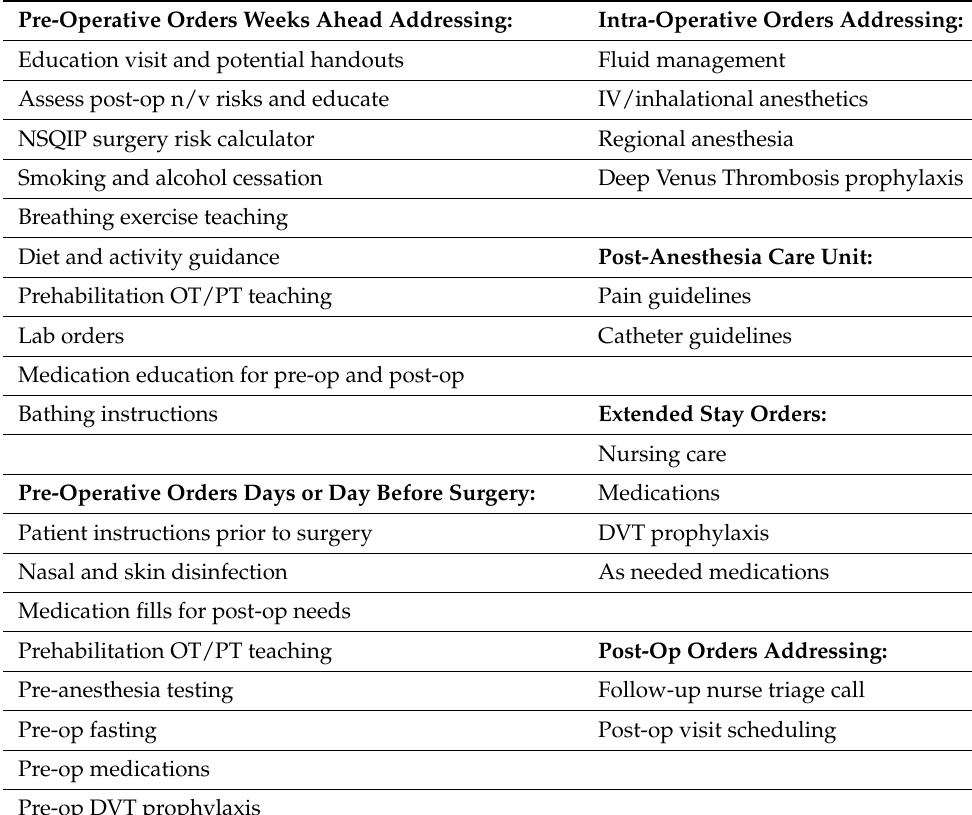
Table 1. Detailed timing and order categories to address in ERAS pathways cancer surgeries. Pre-Operative Orders Weeks Ahead